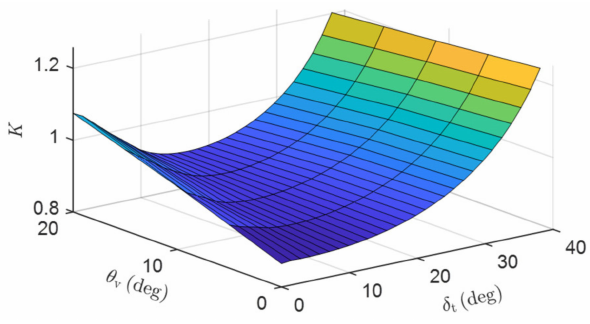
Figure 7. Simulation of the SGCR. When 0 deg < θ v ≤ 20 deg and 0 deg < δ ≤ 40 deg, the SGCR of the vehicle is 0.87 ≤ K ≤ 1.25. This is within an acceptable range (in low-speed vehicles, K should be in the range of 0.4 ≤ K ≤ 1.6)